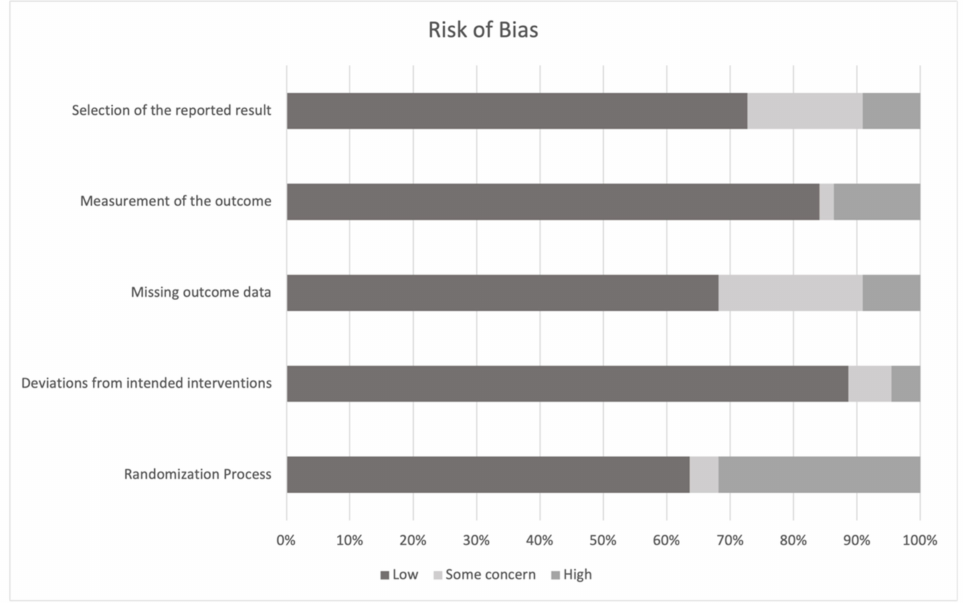
Figure 2. Risk of bias assessment using Cochrane’s RoB2